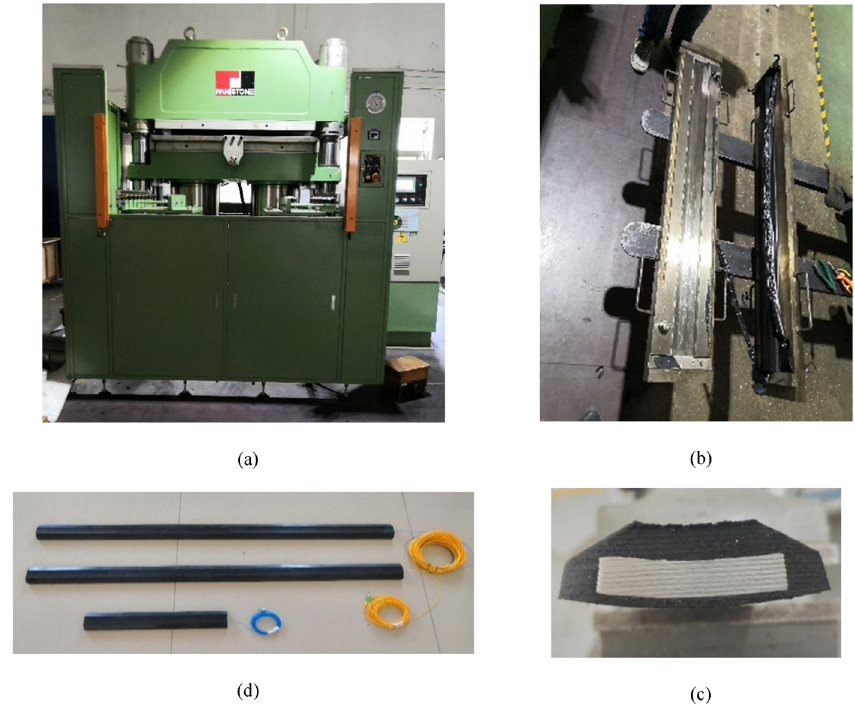
Figure 10: The primary processes involved in implanting fi ber gratings into the rubber stave: ( a ) compression vulcanization molding, ( b ) the rubber stave removed from the mold, ( c ) cutting section, and ( d ) fi nished product.